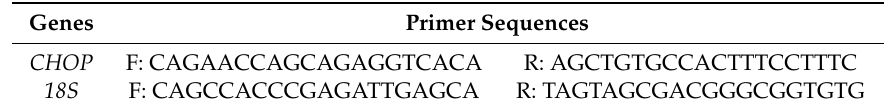
Table 1. List of primers used for real-time reverse transcription-polymerase chain reaction (RT-PCR).